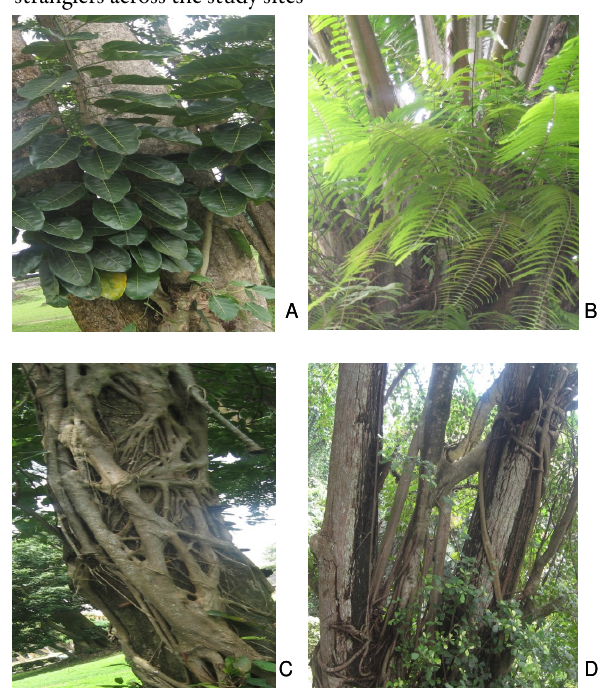
Fig. 4. Epiphytes and host trees showing different point of attachments and nature of the epiphytes.